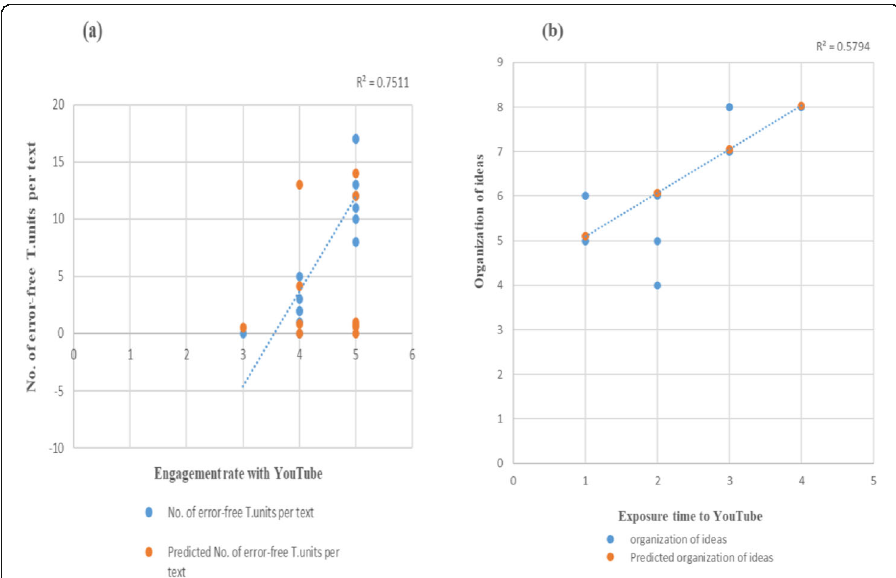
Fig. 1 a Sample of strongly positive linear correlation. b Sample of moderately positive linear